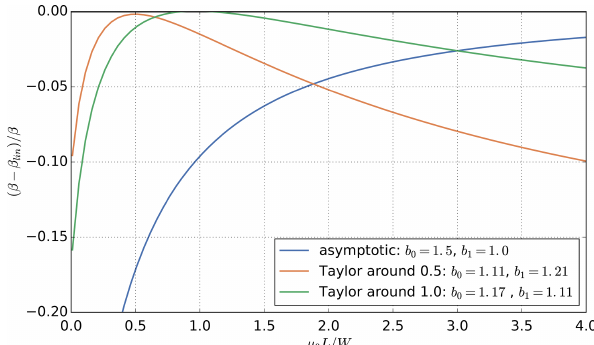
Figure A1. The relative difference between β given by Eq. (A3) and different linear approximations of β